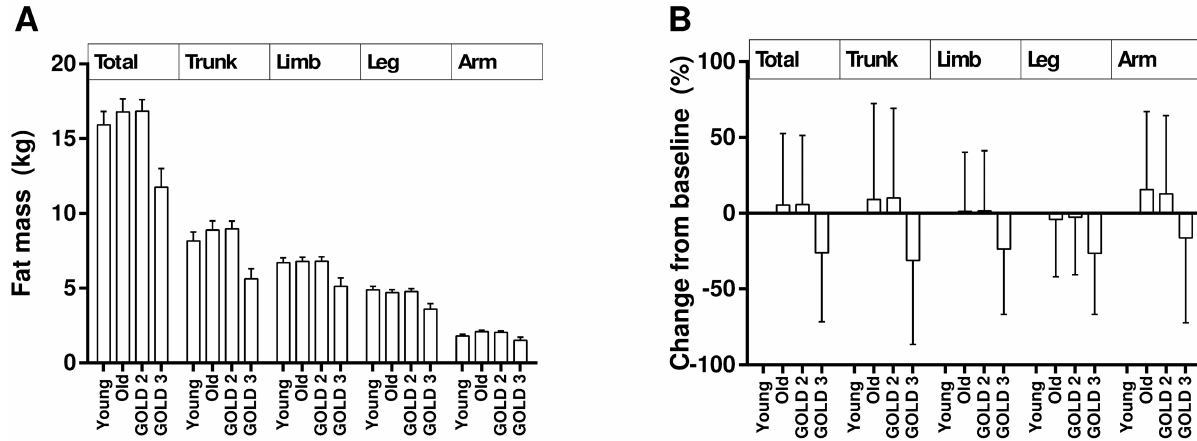
Fig 2. Changes in fat depots. (A) Total and segmentalfat depot changes amonggroups. (B) Percentage changes of total and segmental fat mass variablesfrom baselineof the healthyyoung adult group. Data were expressedin the form of mean ± standard error of mean.